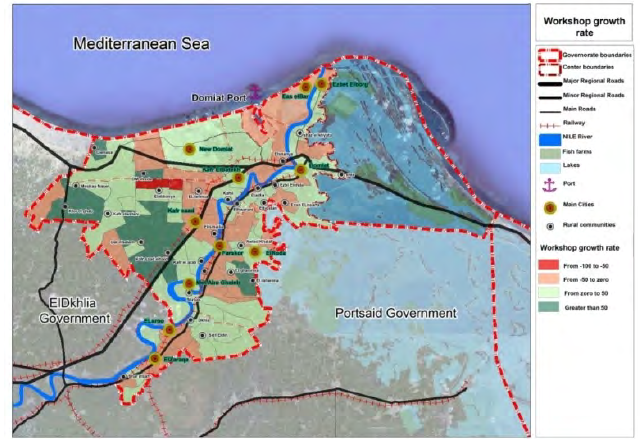
Figure 7. Growth of workshops